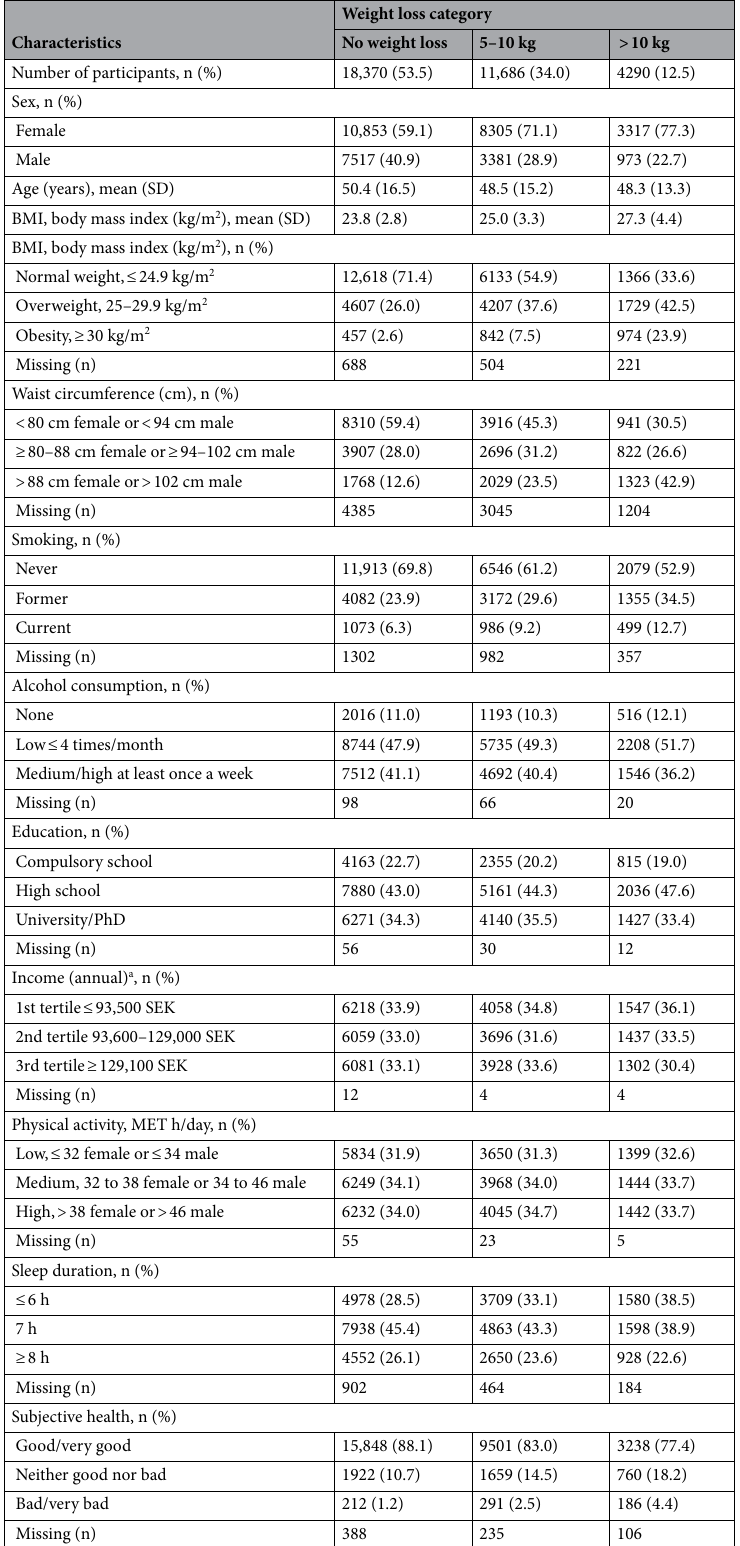
Table 1. Baseline characteristics of study participants by categories of prior weight loss (n = 34,346). MET metabolic energy turnover. a Information was retrieved from the Lisa Database in 1997. SEK is the currency code for the Swedish